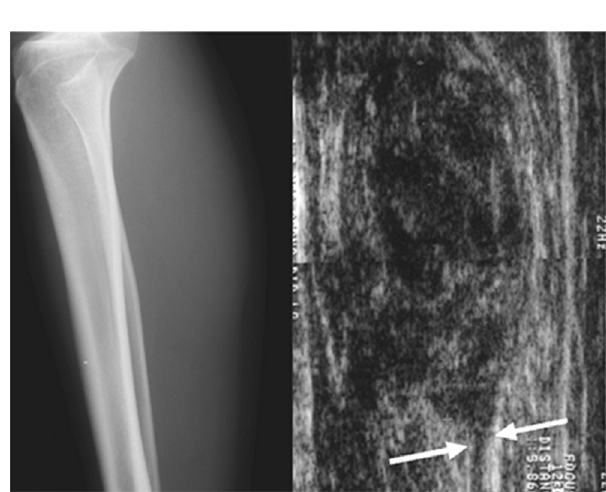
Figure 1 - A giant thrombosed venous aneurysm in the calf. Lateral radi- ography showed only questionable and nonspecific soft tissue enlargement. Ultrasound images demonstrated the continuity between the mass and the neurovascular bundle in the longitudinal axis. The soft tissue mass was heterogeneous based on ultrasound